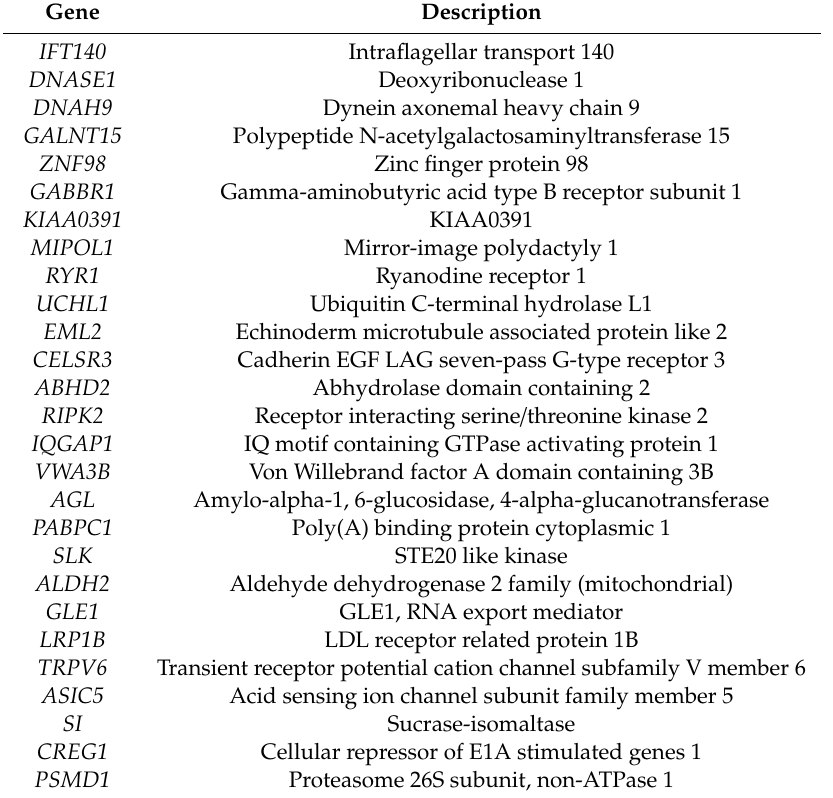
Table 1. List of mutations predicted by CONDEL for progression stage.